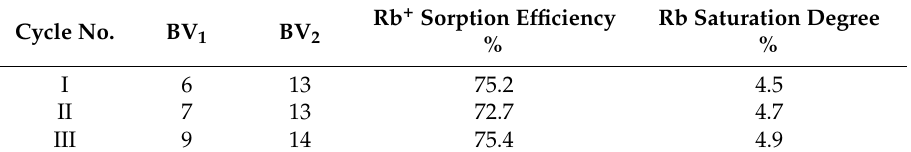
Figure 3. Characteristics of PFC100x10 during sorption.